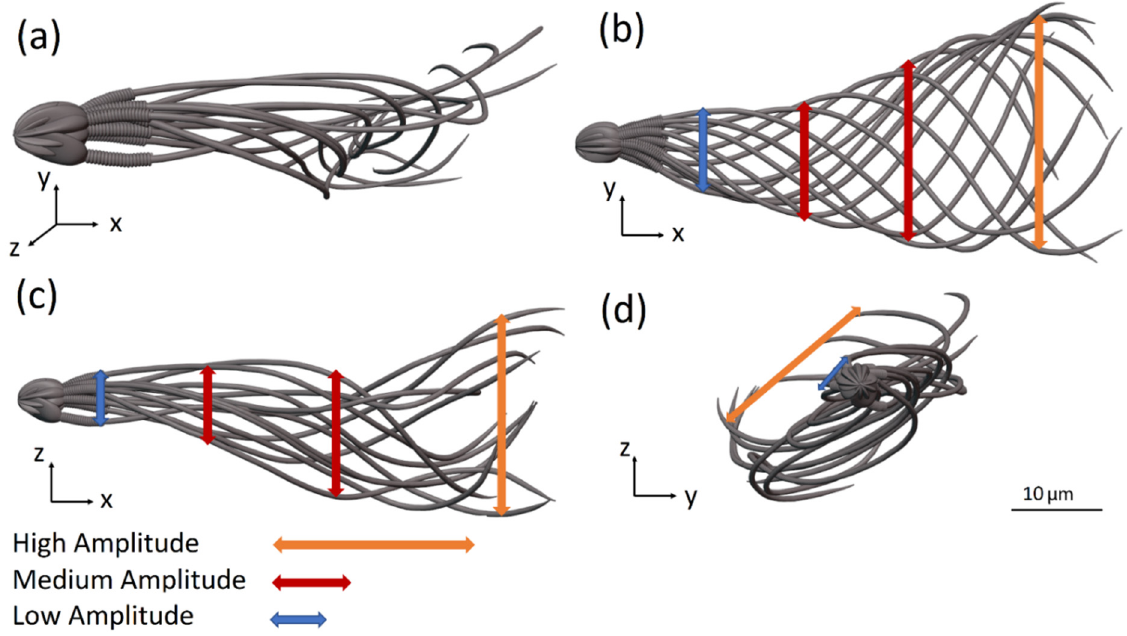
Figure 4. Flagellar beating of a normal sperm model with clamped head (held at its tip). ( a ) Wave form of the 3D flagellar beating. ( b – d ) The projections of the 3D flagellar beat in three orthogonal planes.